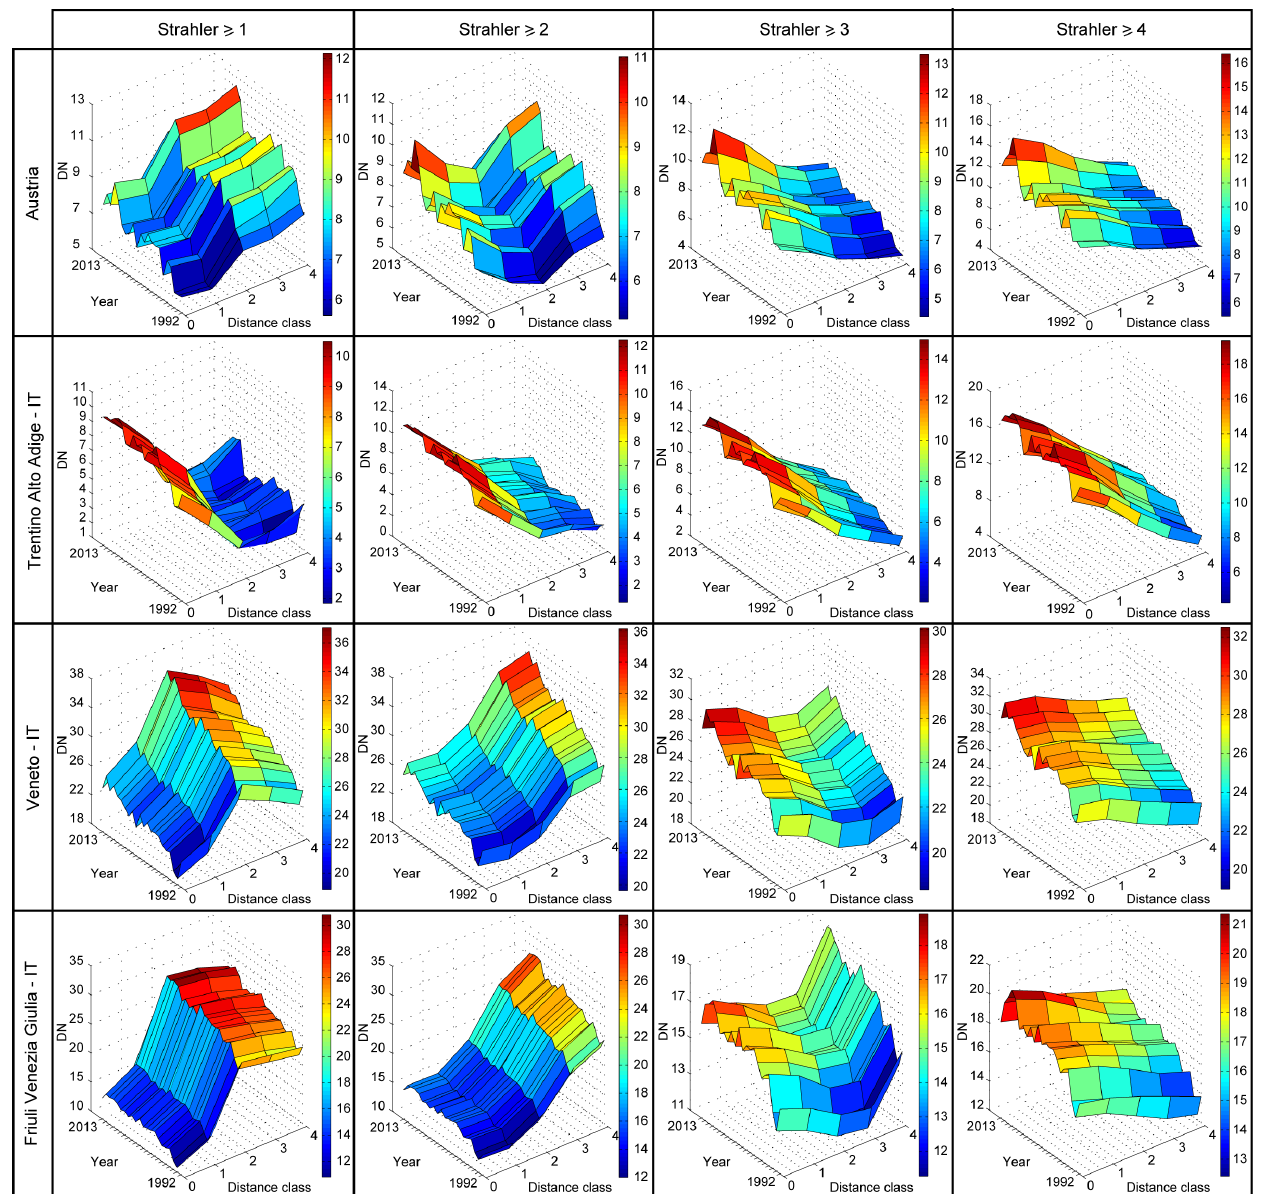
Figure 2. Spatial and temporal trend of yearly nightlight values in Austria (first row), Trentino Alto Adige (second row), Veneto (third row) and Friuli Venezia Giulia (forth row). Columns 1, 2, 3 and 4 refer to CCM river pixels with Strahler order ≥ 1, ≥ 2, ≥ 3 and ≥ 4, respectively. Distance classes 0, 1, 2, 3 and 4 correspond to: river pixels, 1, 2, 3 and 4km far from the river network,